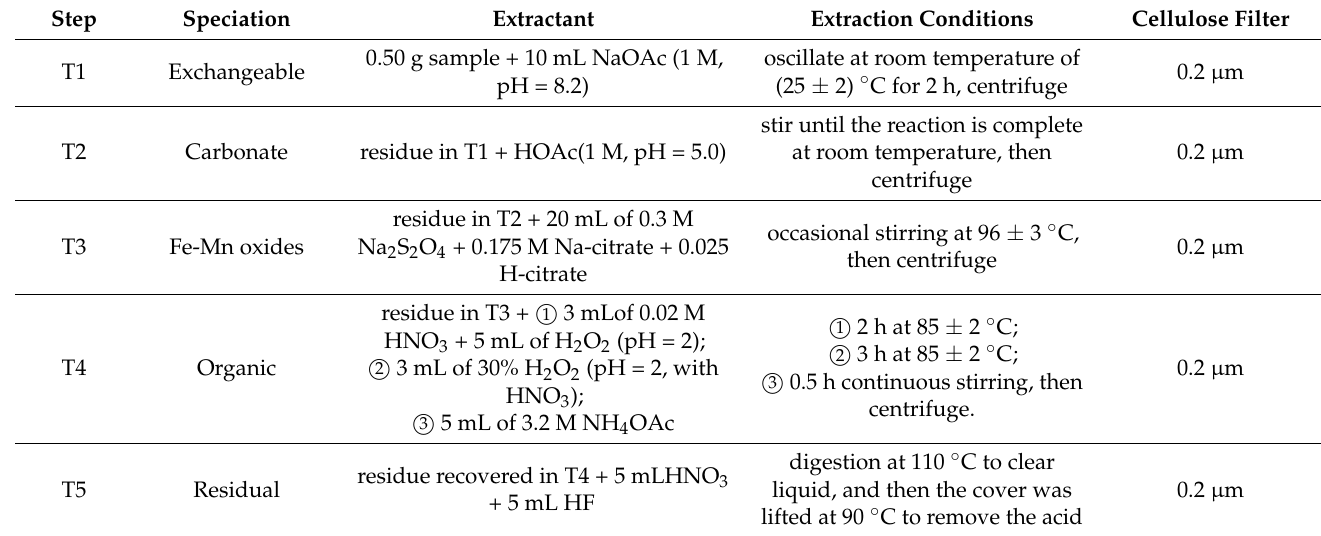
Table 1. Sequential chemical extraction procedure used for TREs